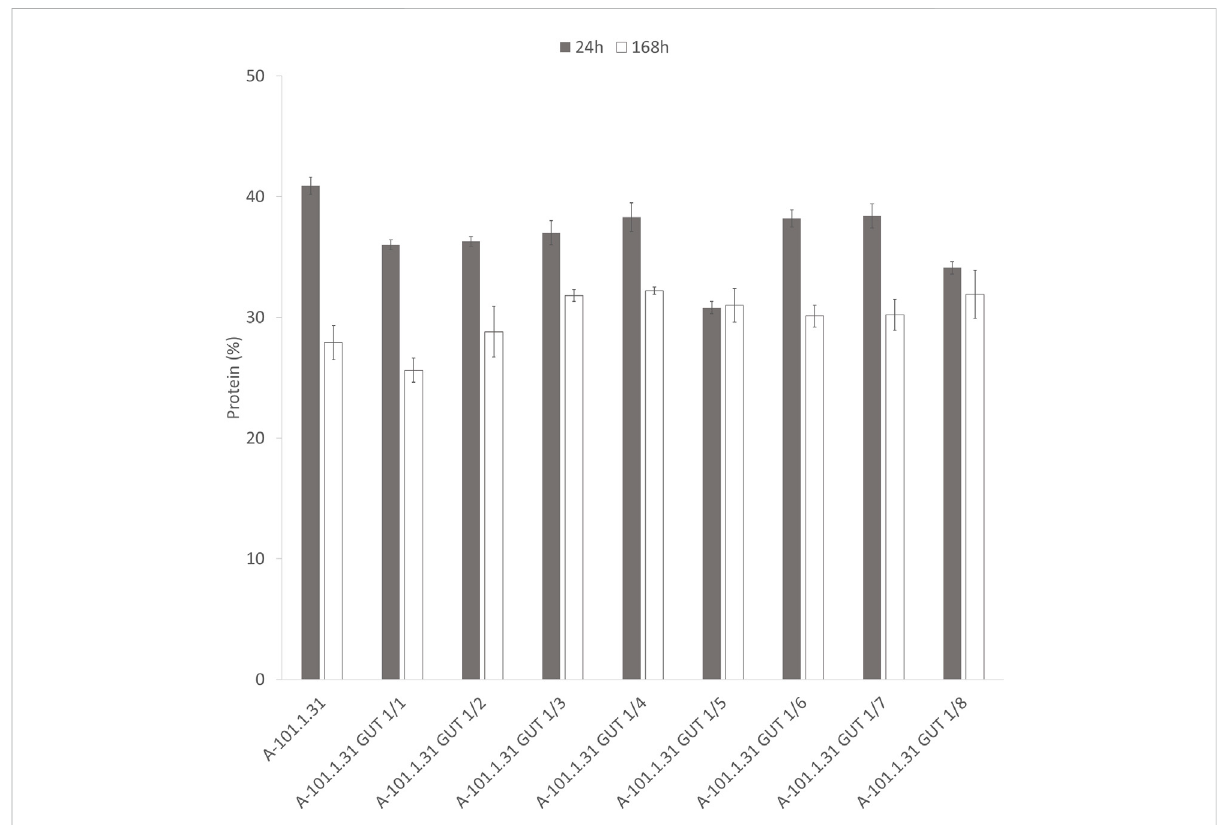
FIGURE 3 Protein content of Y. lipolytica biomass (WT and GUT1 transformants) during kynurenic acid production in batch bioreactor cultures on waste glycerol ( ■ ) 24 h of the culture and ( □ ) 168 h of the